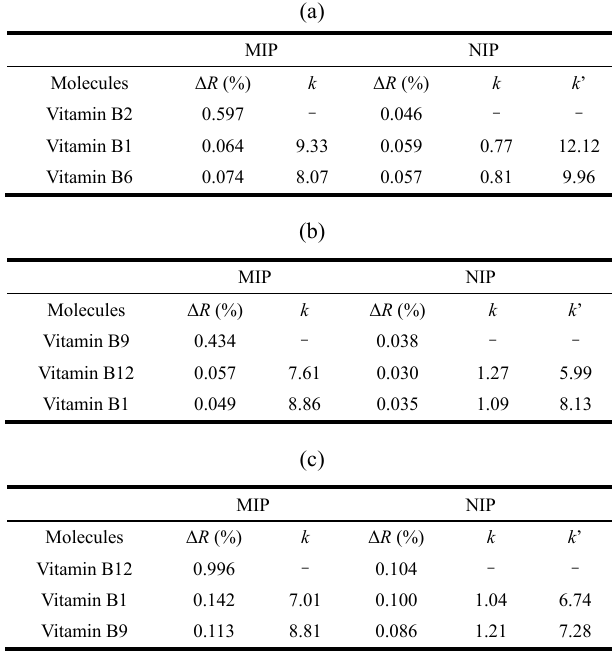
Table 3 Selectivity and relative selectivity coefficients for competitive molecules [(a) vitamin B2, (b) vitamin B9, and (c) vitamin B12 imprinted SPR sensors].